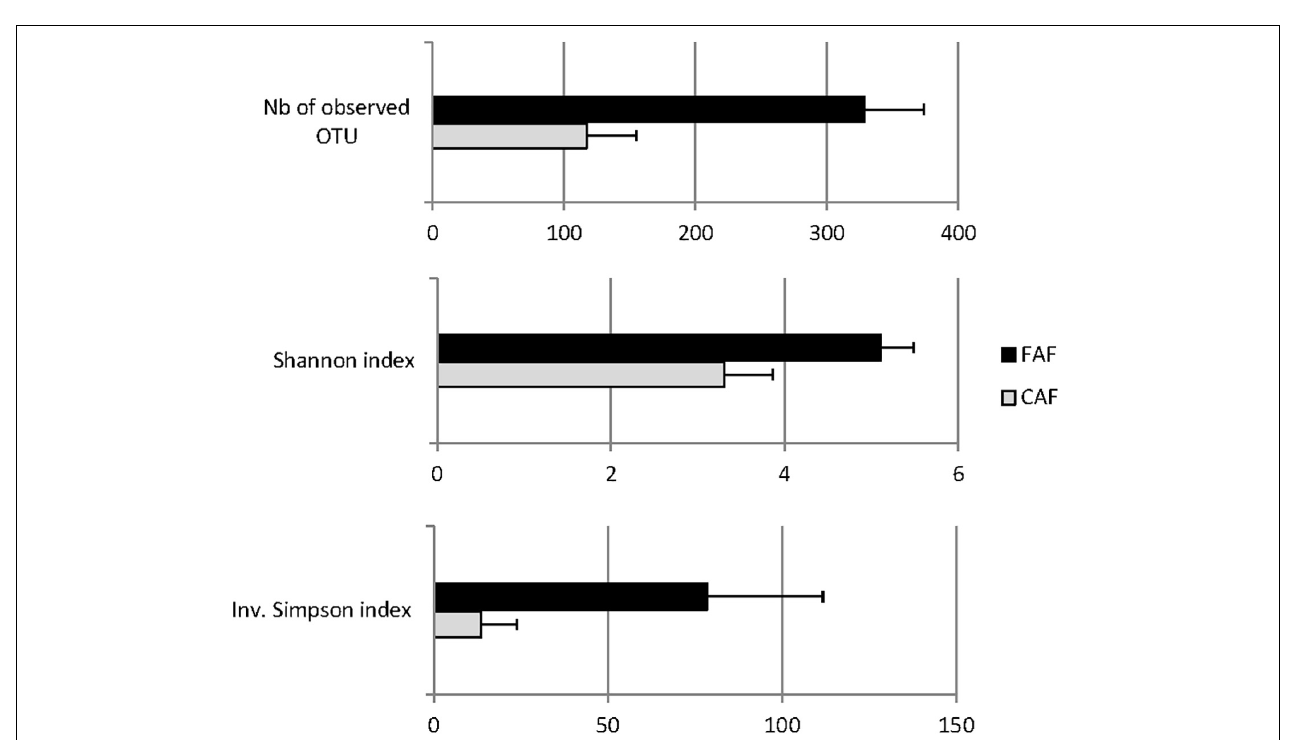
Frontiers in Microbiology |